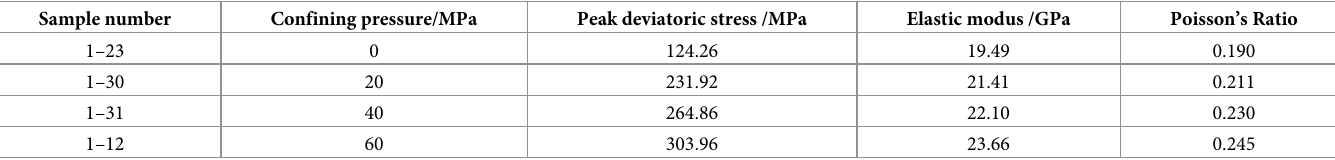
Table 1. The mechanical parameters of shale under conventional triaxial compression